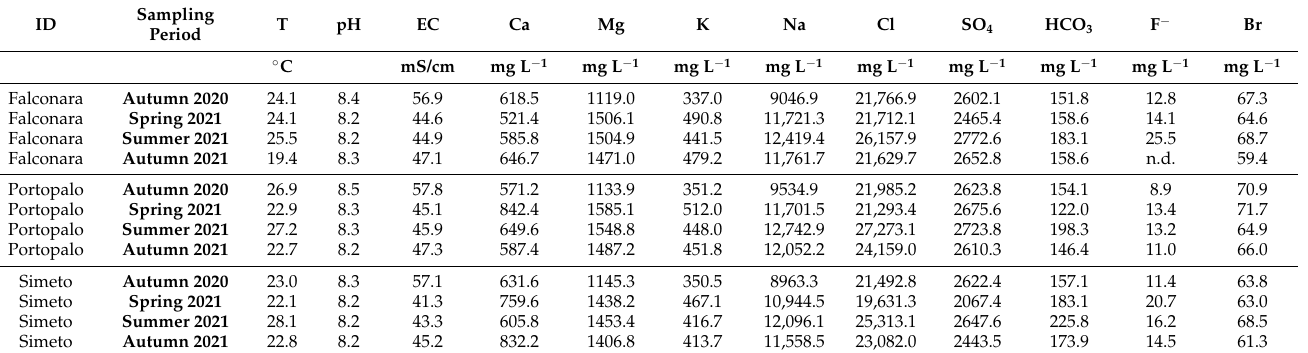
Table 3. Physico-chemical parameters and concentrations of major components of seawater sampled at the Portopalo, Simeto, and Falconara sites. HCO 3 represents alkalinity in mg of HCO 3 L − 1 . Each seasonal value represents the average of the two samples that were collected. n.d.= not